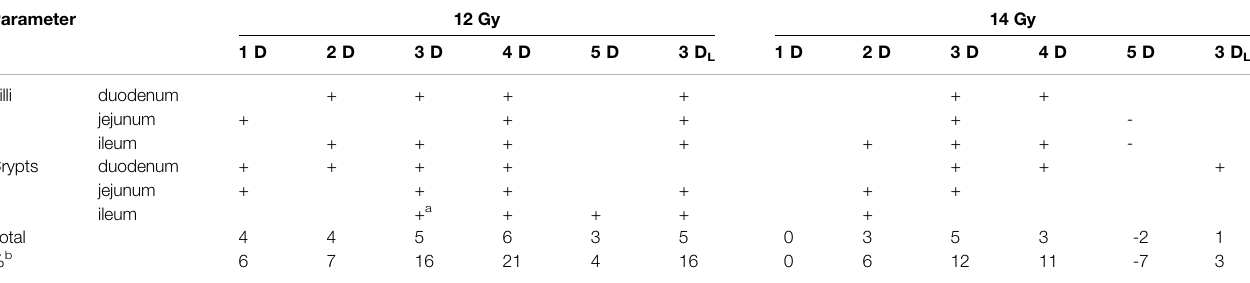
+ and - represent signi fi cant changes (increase and decrease, respectively) compared with solely irradiated groups. D: dosage regimens starting at 1 h after irradiation. D L : three-dose regimen beginning 24 h after irradiation. a To sum percentage changes in the 3 D group irradiated by 12 Gy, the length of crypts in the ileum was increased by 12% due to a signi fi cantly higher number of surviving crypts. b Average change per compartment.